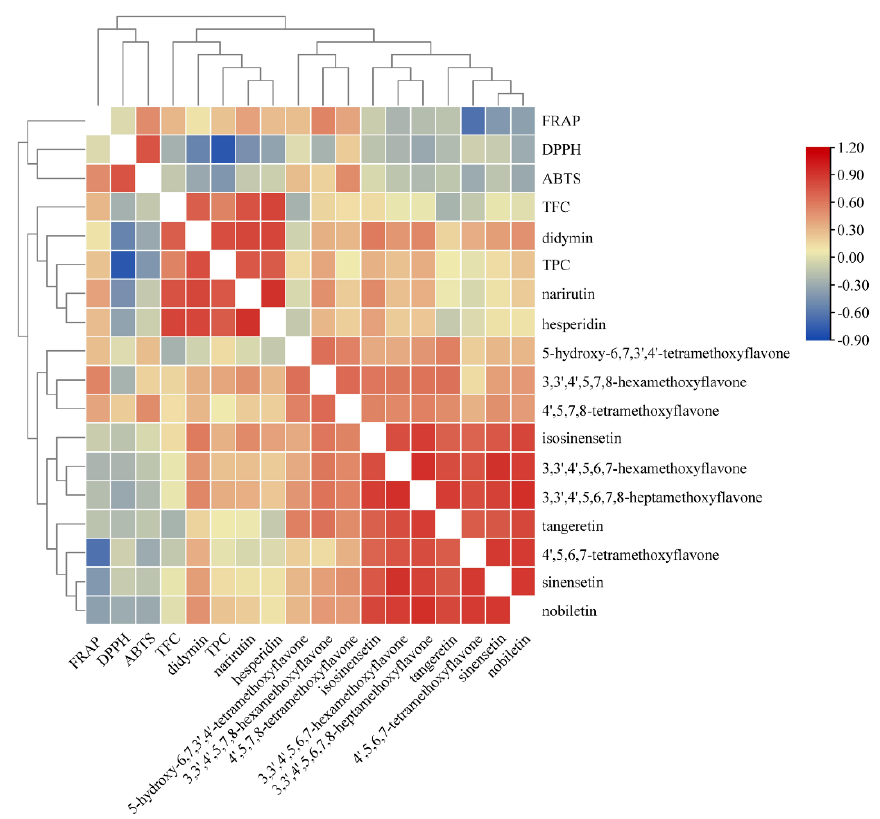
Figure 2. Pearson’s correlation analysis among all variables under investigation.